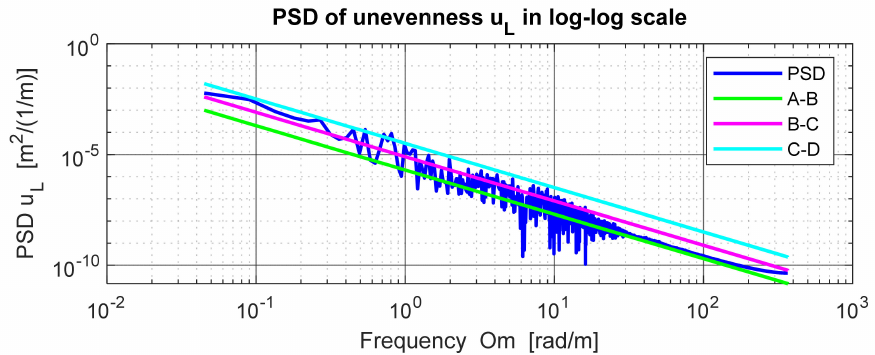
Figure 4. Power spectral density (PSD) of left road profile in log-log scale.